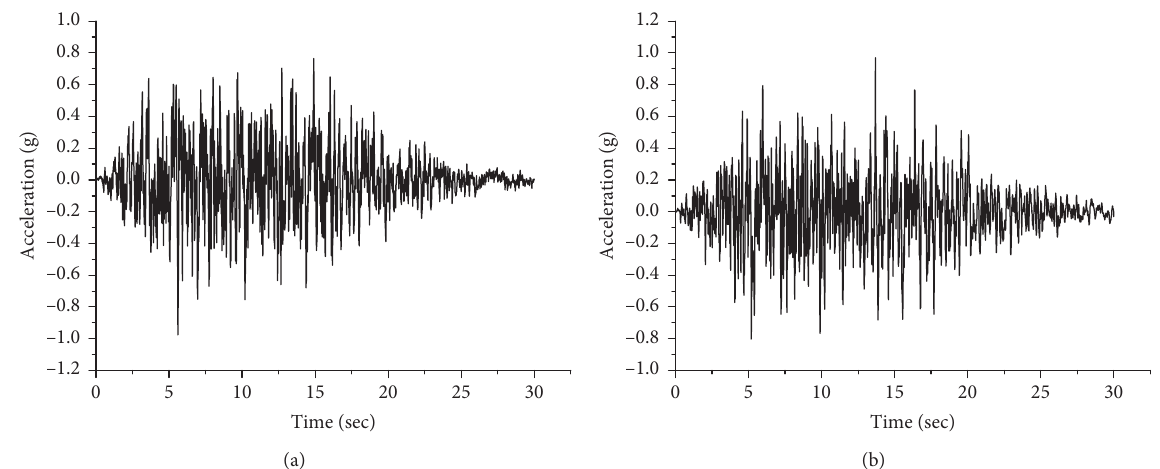
Figure 3: Time histories of normalized acceleration. (a) Vertical. (b) Along the river.